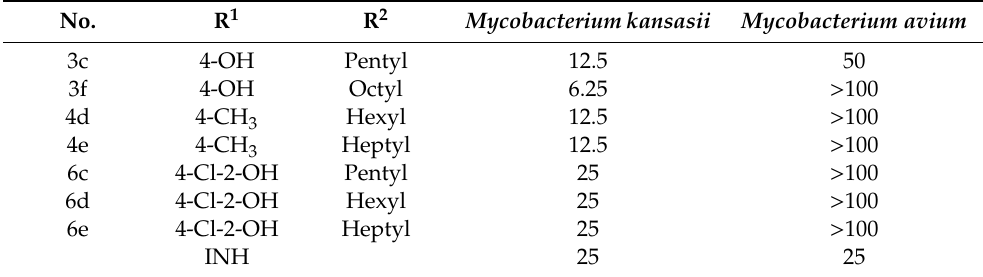
Table 2. In vitro antimycobacterial activity (expressed as MIC in µ g / mL) against non-tuberculous mycobacterial strains of M. kansasii and M. avium .